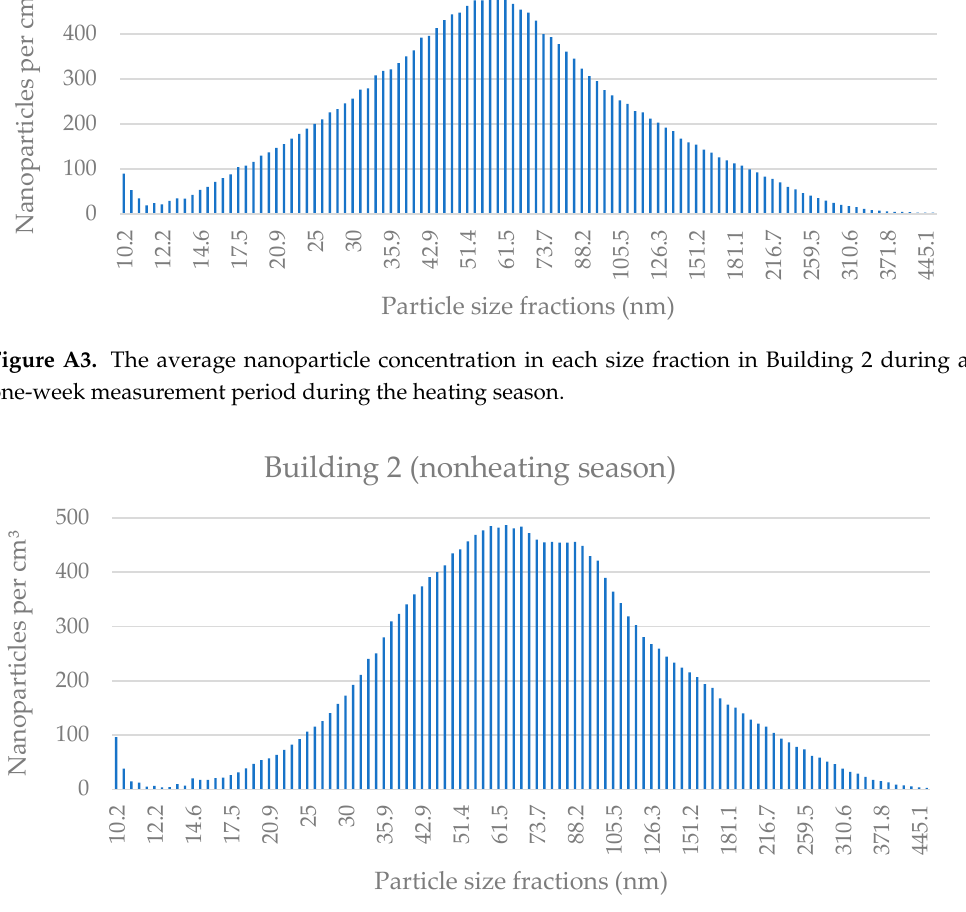
Figure A4. The average nanoparticle concentration in each size fraction in Building 2 during a one-week measurement period during the nonheating season.